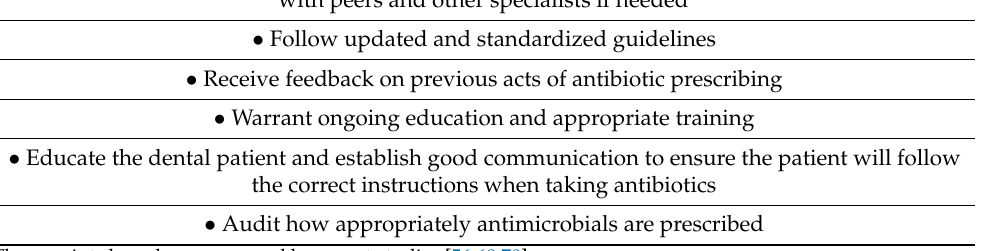
Table 1. Antibiotic stewardship interventions in dental